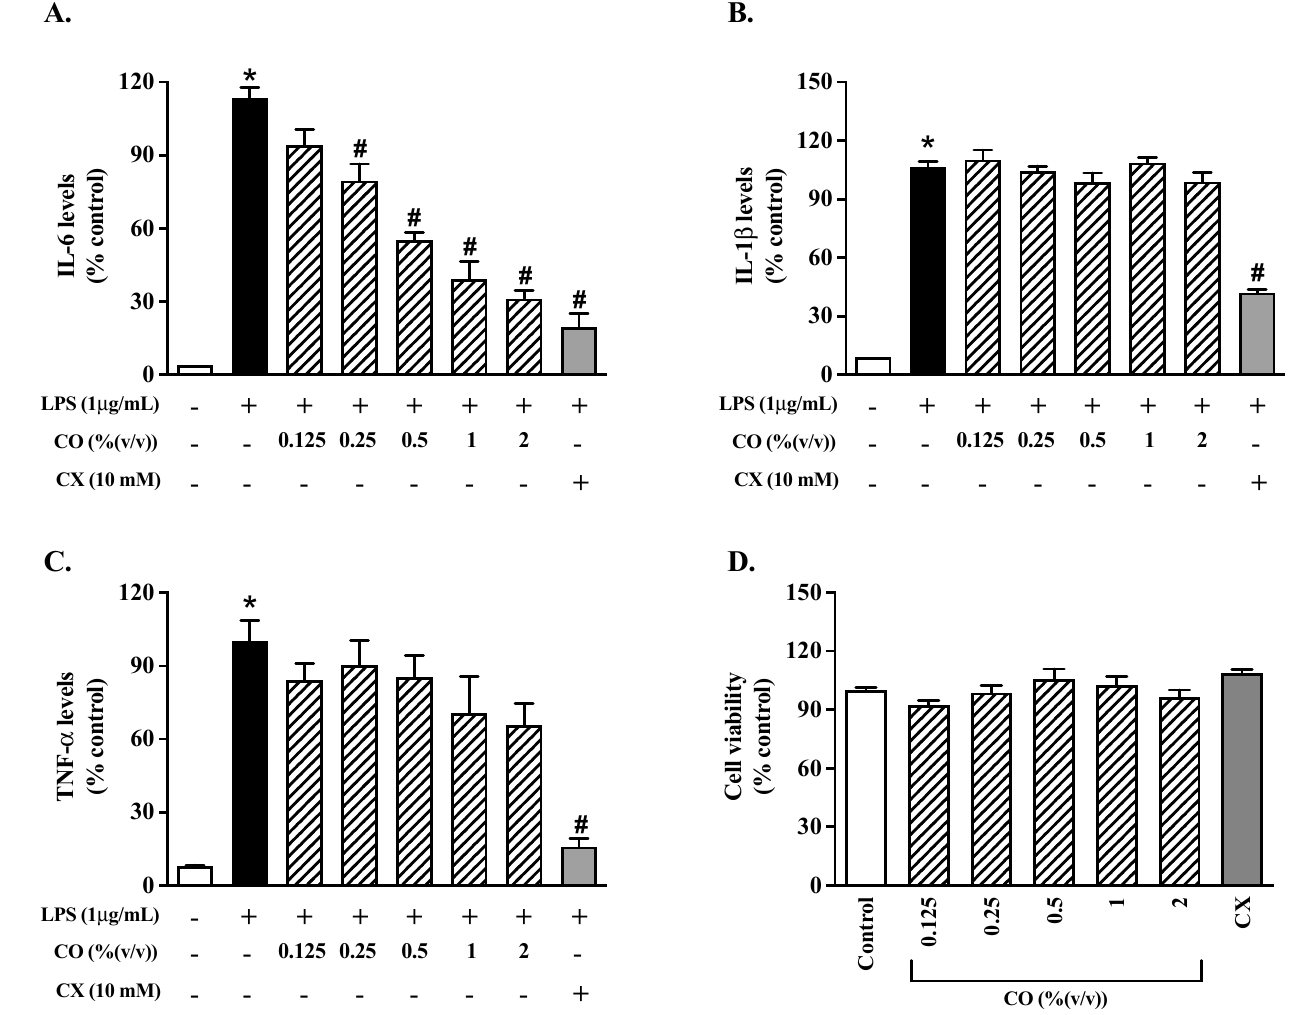
Figure 1. The effects of CO on the production of inflammatory cytokines. For 24 h, cells were treated with varying doses of CO with or without LPS. ( A – C ) There were ELISA tests for IL-6, IL-1 β , and TNF- α , respectively, to determine the levels of production of these three cytokines. RAW 264.7 cell viability was tested for 24 h at various CO concentrations ( D ). Values displayed are mean ± S.E.M. ( n = 5), * p < 0.05 vs. control and # p < 0.05 vs. LPS.